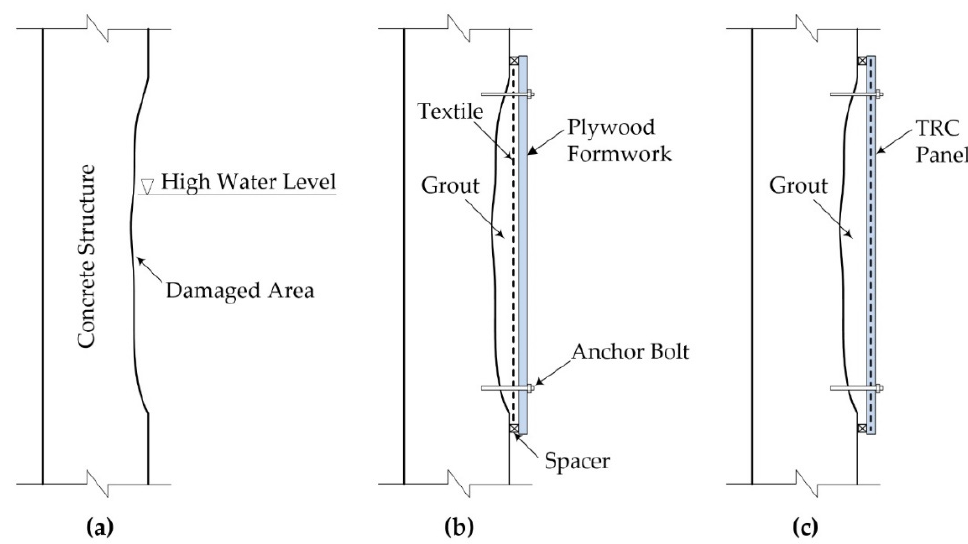
Figure 6. ( a ) Damaged concrete structure; ( b ) TRC grouting system with removable formwork; ( c ) TRC grouting system with TRC panel.